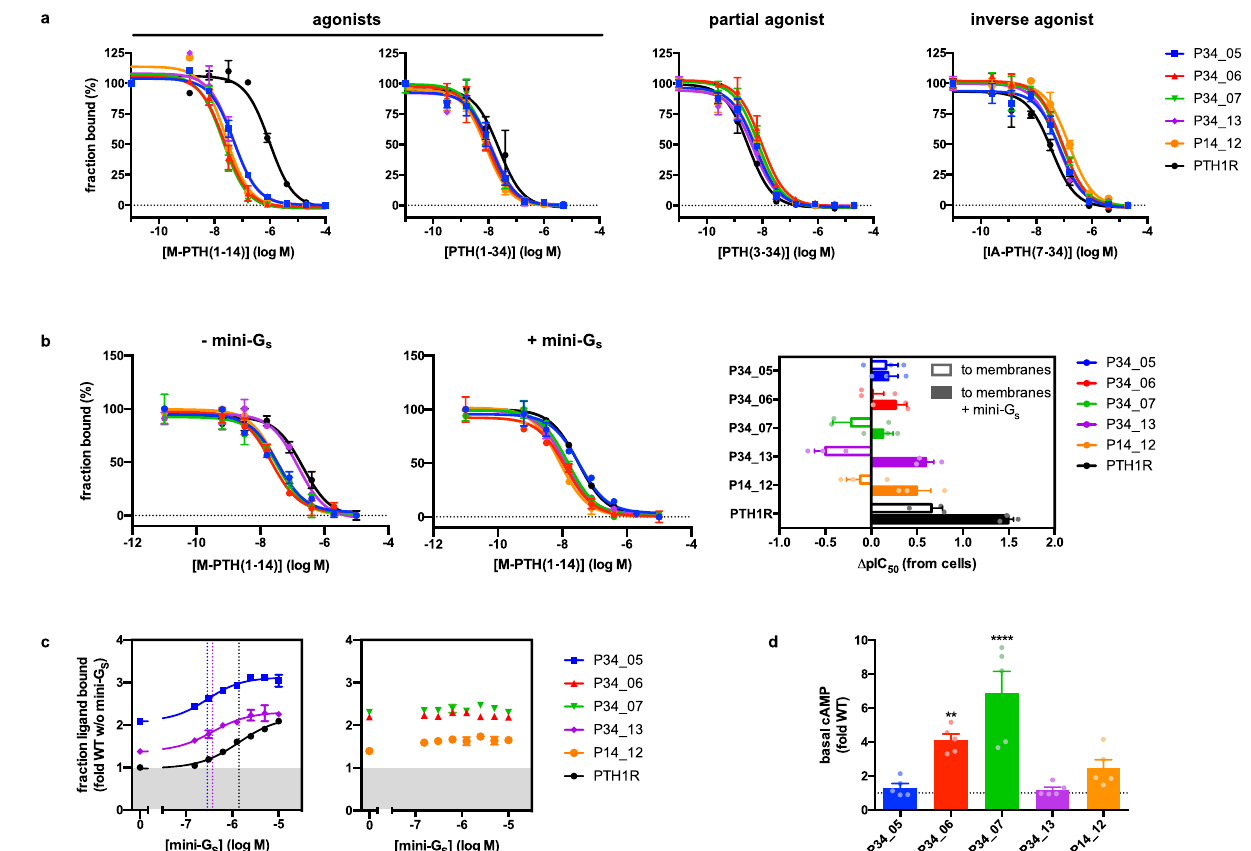
Fig. 4 | Evolved PTH1R variants more easily adopt the active state. a Evolved PTH1R variants exhibit high-af fi nity agonist binding but equal or reduced af fi nity forpartialorinverseagonistsincells.Competitionligandbindingcurvesoffull[M- PTH(1 – 14)andPTH(1 – 34)],partial[PTH(3 – 34)] and inverse agonist[IA-PTH(7 – 34)], measured in whole cells expressing wild-type PTH1R or 5 evolved variants. b High agonistaf fi nityofevolvedPTH1Rvariantsissimilartothatofwild-typePTH1Rinthe G protein-bound state. Ligand binding curves of M-PTH(1 – 14) to evolved PTH1Rs weremeasuredinmembranefractions,obtainedfromcellsexpressingPTH1Rwild- typeor5evolvedvariants,intheabsence(leftpanel)orpresence(middlepanel)of 12.5 µ M mini-G s . Relative binding constants obtained by competition of M- PTH(1 – 14) binding with labeled M-PTH(1 – 14), measured in whole cells (from a ) vs. membrane fractions in the absence or presence of 12.5 µ M mini-G s (right panel). Positive values thus re fl ect stronger binding on membrane fractions than on cells. c Increased agonist af fi nity is G protein-dependent. Binding of40nM M-PTH(1 – 14)